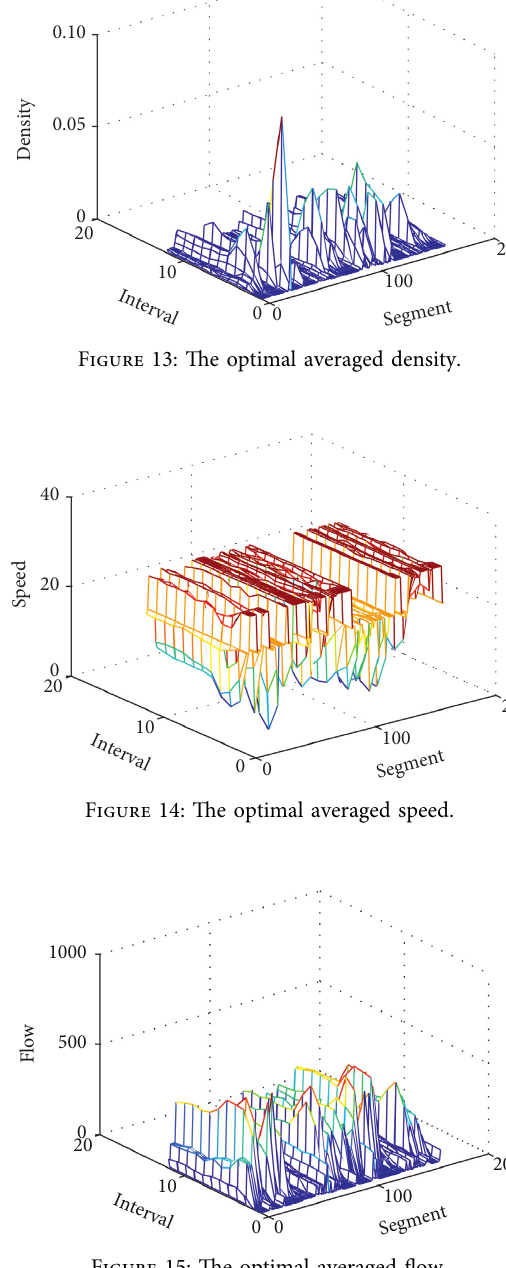
Figure 15: The optimal averaged flow.